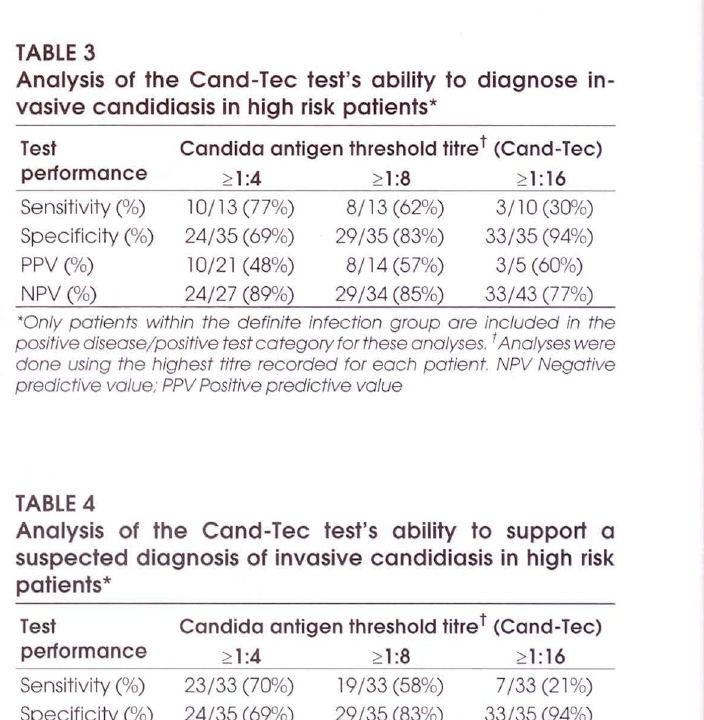
Analysis of the Cand-Tec test's ability to support a suspected diagnosis of invasive candidiasis in high risk patients*